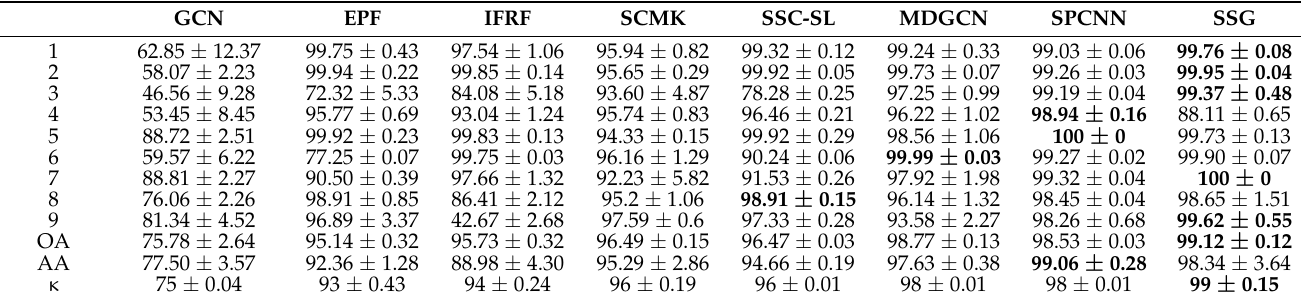
Table 3. Statistical results (%) of seven competitive algorithms and the proposed method for Pavia University